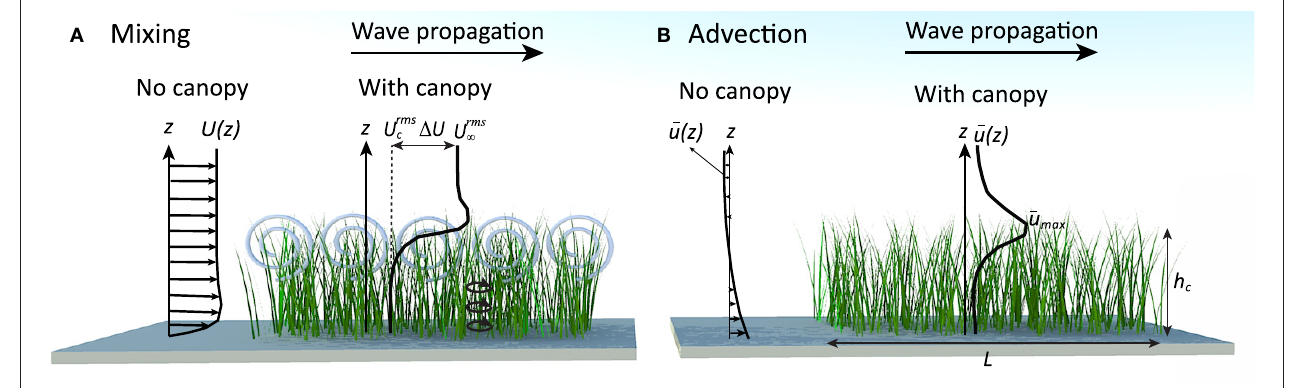
FIGURE 1 | Interactive effects of wave-dominated flows over submerged canopies. (A) The strong velocity gradient at the canopy top causes the generation of large scale KH-vortices in this region (gray spirals). These vortices, together with wake turbulence (small circles inside the canopy), control rates of vertical mixing in coastal canopies. (B) The asymmetry in particle motion (resulted from the canopy drag) causes the generation of a strong mean drift ( u ) within a confined region above the canopy (Abdolahpour et al., 2017b). Note, h c and L indicate the height and length of a typical canopy,